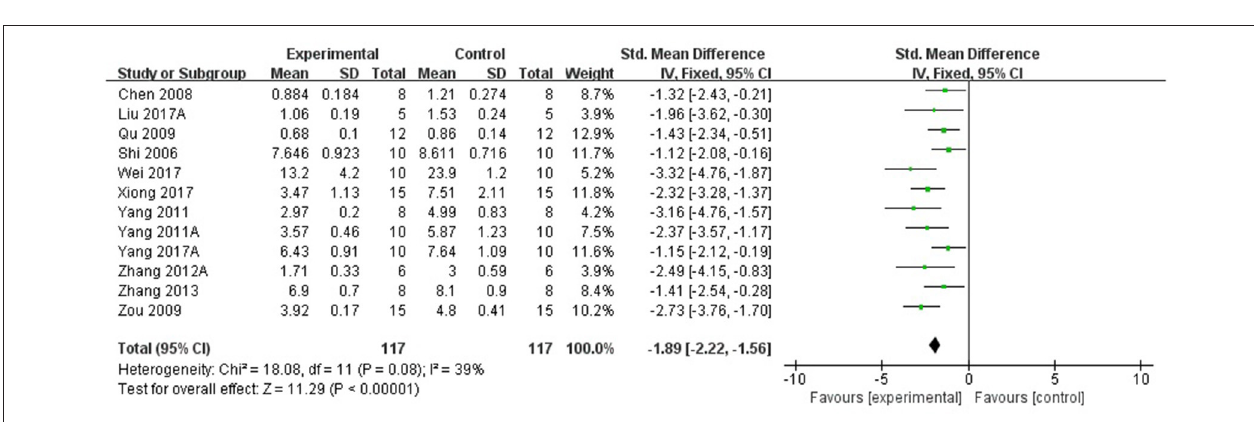
difference was overlooked in the included study.